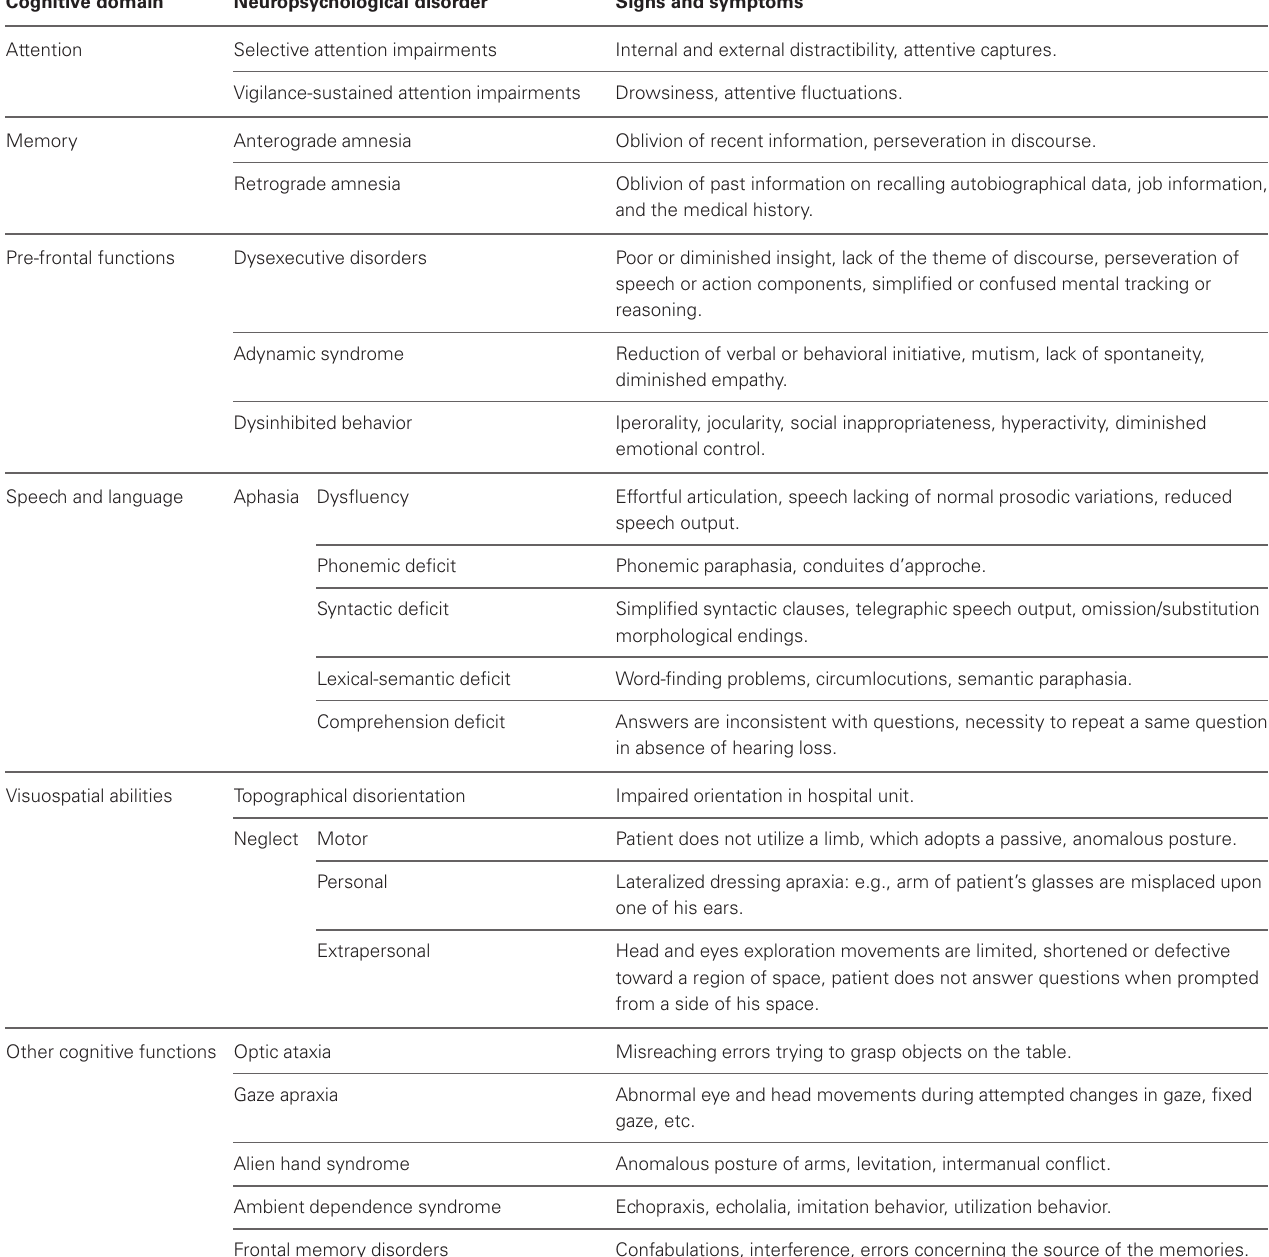
Table 1 | Possible signs and symptoms of some cognitive impairments, detectable with the preliminary Neuropsychological Examination